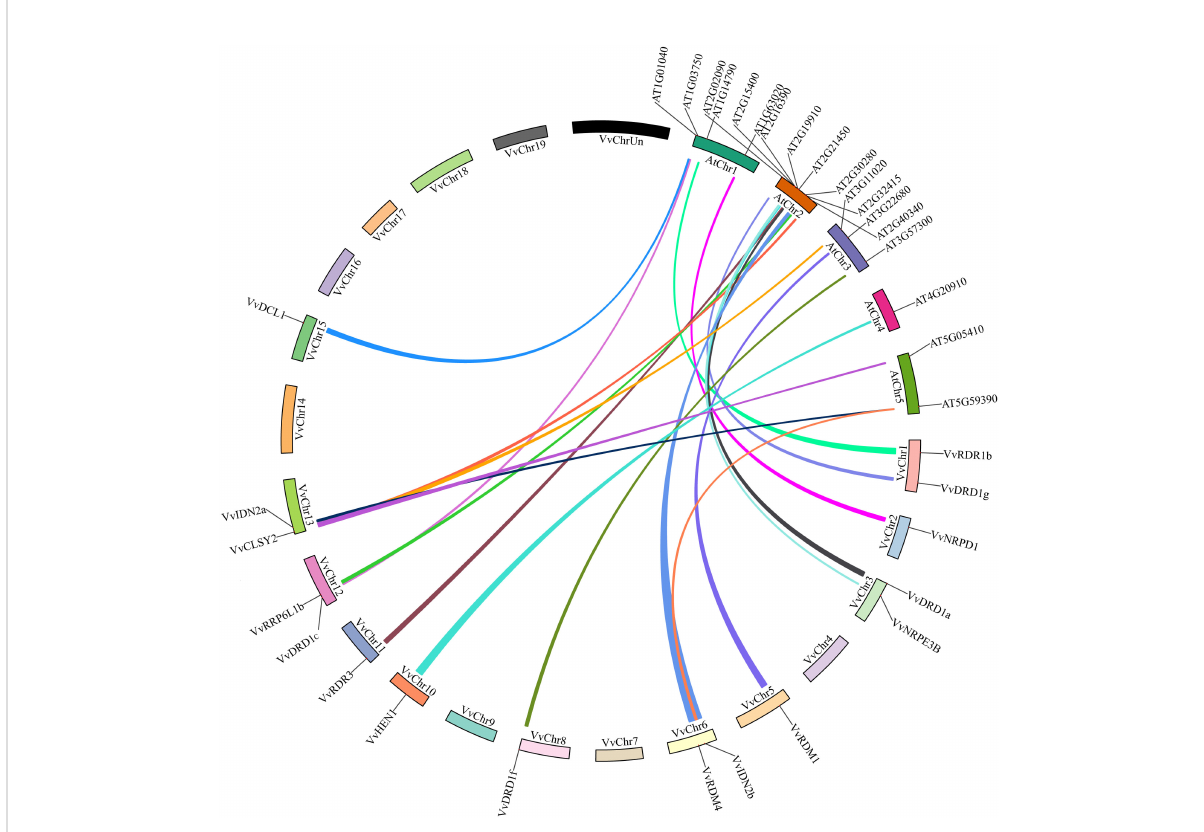
FIGURE 6 Synteny analysis of VvRdDM genes between grapes and Arabidopsis. Relative positions were estimated according to the grape and Arabidopsis chromosomes; colored lines denote syntenic